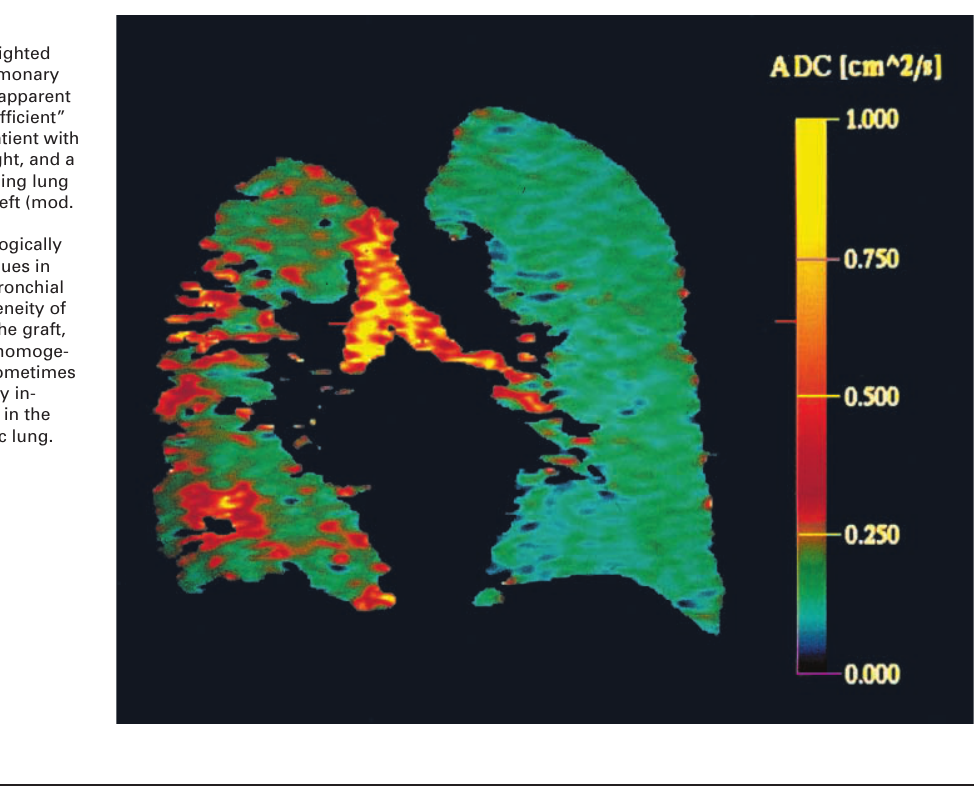
Normal and acceler- ated decay of 3 He signal intensity at normal (F ET O 2 = 0.16) and increased (F ET O 2 = 0.35) end-tidal (and hence, alveolar) O 2 concentration in a porcine lung (trans- verse orientation). F ET O 2 , end-tidal fraction of oxygen.